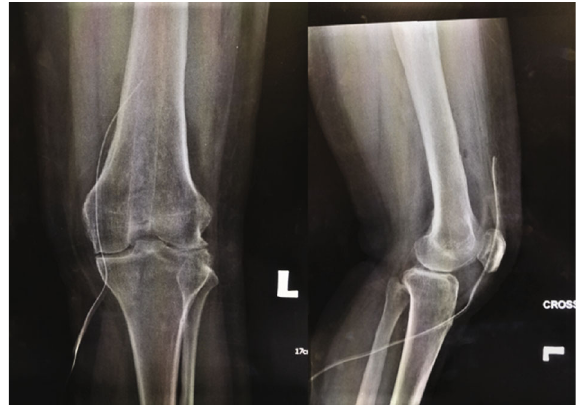
Figure 5: X-rays of left knee post K-nail removal.